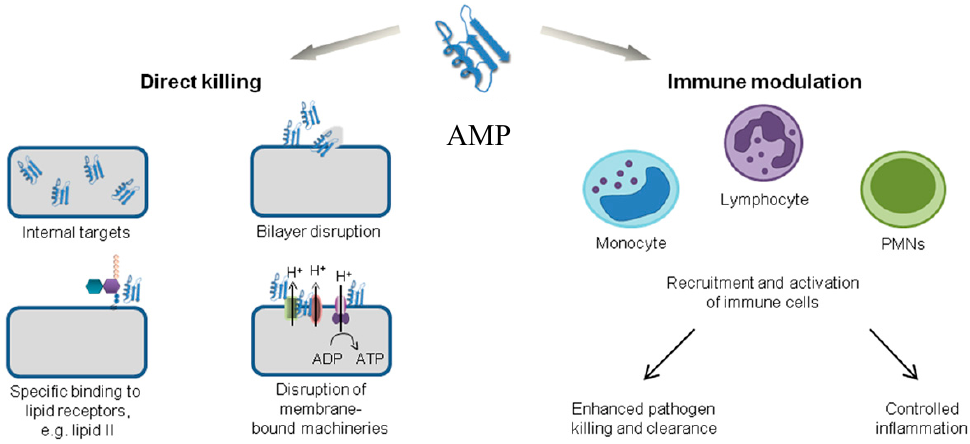
Figure 3. Various mechanisms of action of antimicrobial peptides. Adapted with permission from [54]. MN: polymorphonuclear neutrophils; ADP: adenoside diphosphate; ATP: adenoside triphosphate.